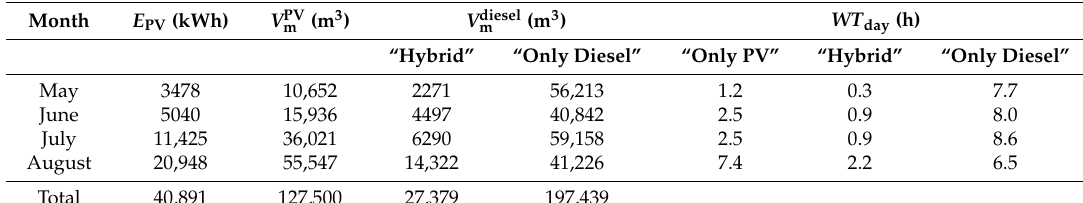
Table 8. Real operational data in 2018.